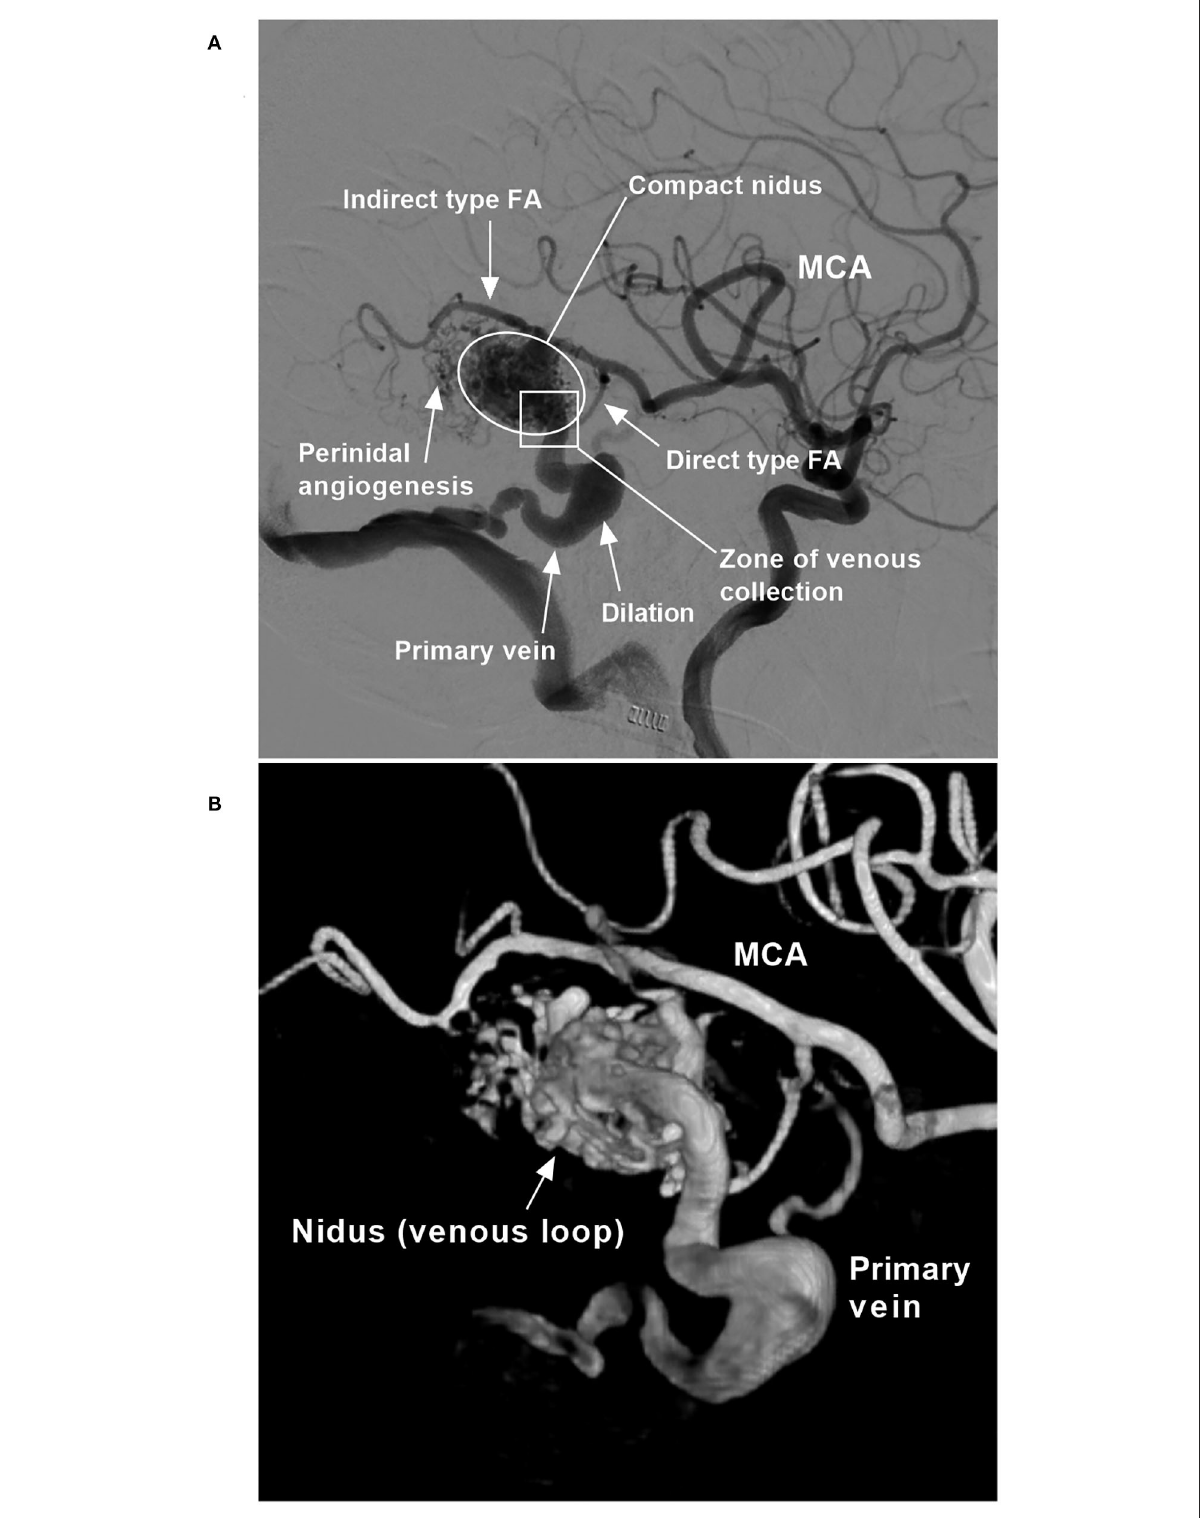
FIGURE1 BAVM angioarchitecture (case 6). (A) Two-dimensional angiogram. (B) Angiogram with a three-dimensional reconstruction. BAVM, brain arteriovenous malformation; FA, feeding artery; MCA, middle cerebral